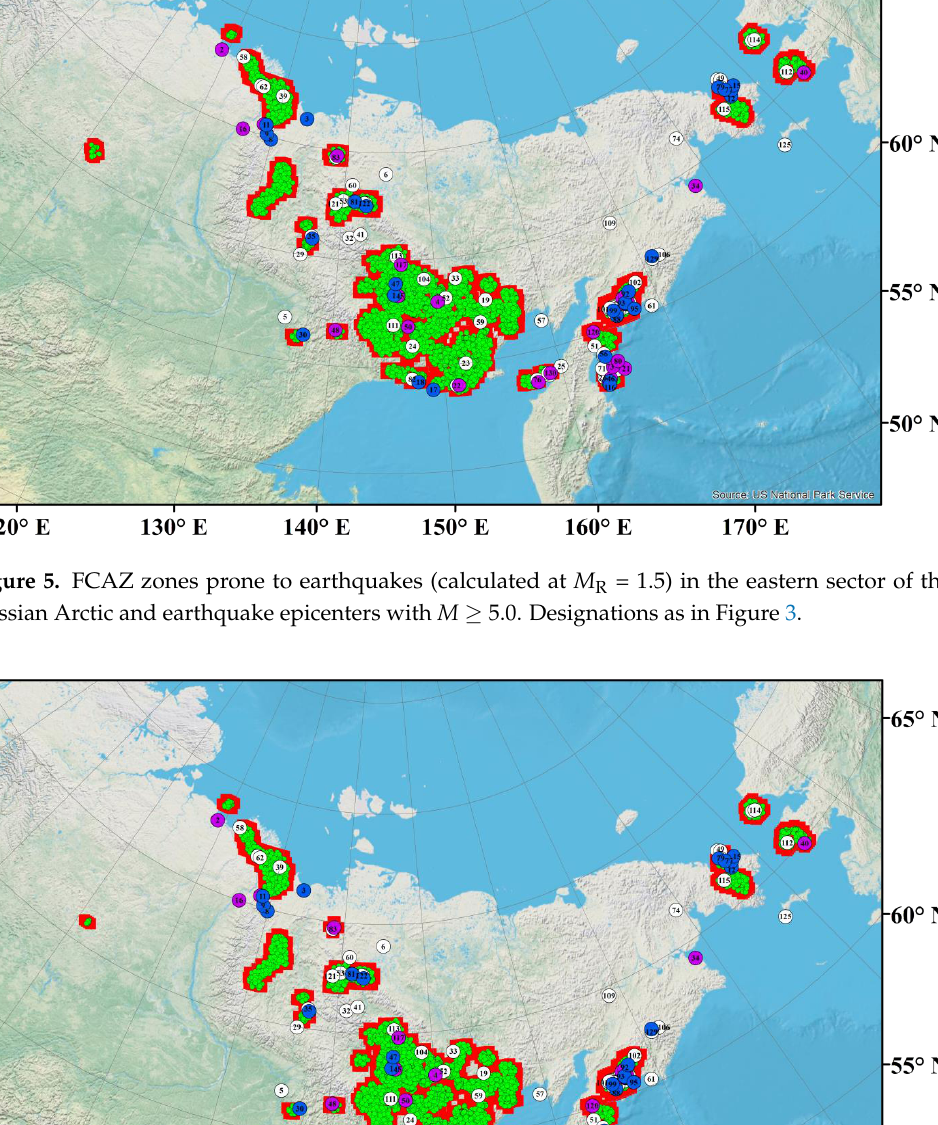
Figure 4. FCAZ zones prone to earthquakes (calculated at M R = 2.0) in the eastern sector of the Rus- sian Arctic and earthquake epicenters with M ≥ 5.0. Designations as in Figure 3.